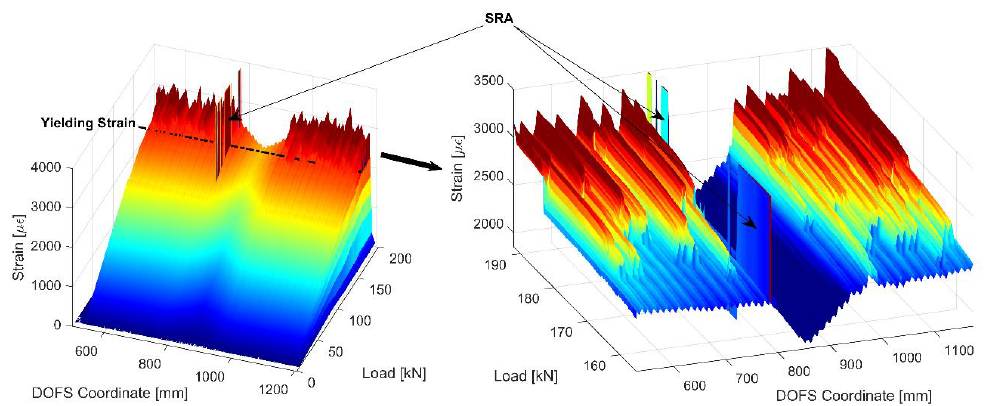
Figure 12. Three-dimensional representation of the strain evolution of member 15D20_21 with a zoom